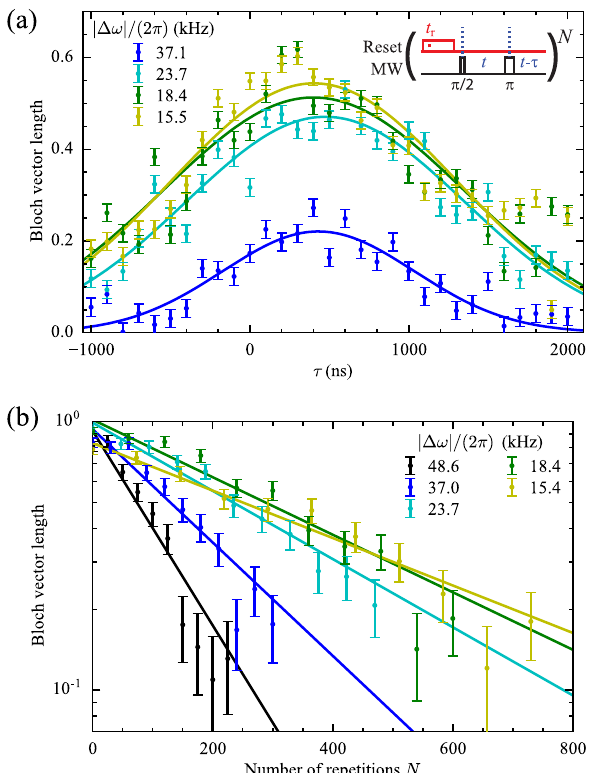
text.FIG. 3. Dephasing of 13 C nuclear spins. (a) Optimization of the dynamical decoupling sequence timing. Different nuclear spins (colors) are initialized in a balanced superposition state and the entanglement sequence is performed N ¼ 200 times. The dura- tion of the second wait interval is swept and the length of the Bloch vector XY projection is measured. All measured nuclear spins exhibit the same broad optimum around 0 . 4 μ s, as can be seen from the Gaussian fit curves. (b) Dephasing of nuclear spins when the number of random reset processes is increased. The data show measurement results of all five individually controlled nuclear spins, where increasing coupling strength leads to steeper decay curves. The solid lines are exponential